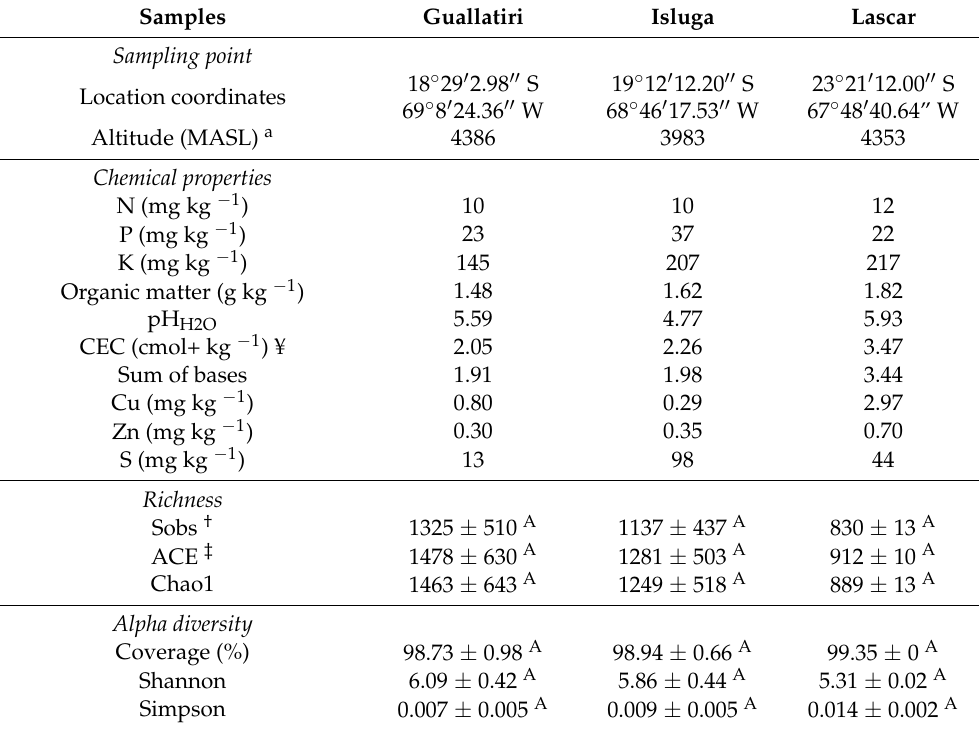
Table 1. Characteristics of sampling sites and total bacterial community of rhizosphere soils from P. quadrangularis plants collected from Guallatiri, Isluga, and Lascar volcanoes. Samples Guallatiri